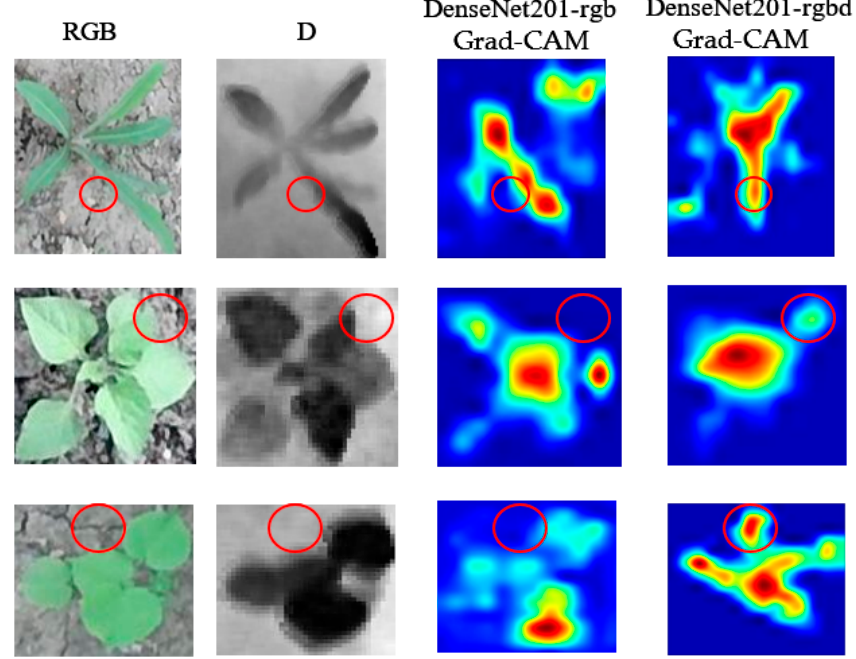
Figure 14. Grad-CAM comparison. This figure shows the visualization results. The red circle in the figure shows the ground area. figure shows the ground